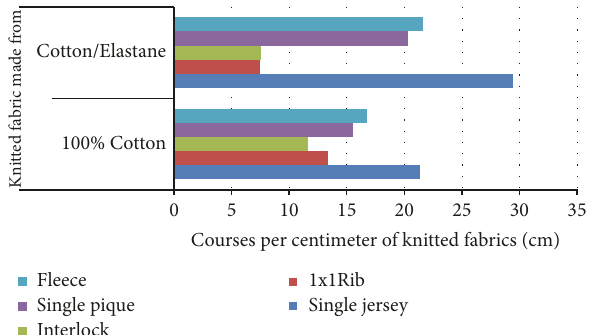
Figure 3: Courses per centimeter (cpc) of knitted fabrics made from 100% cotton and cotton/elastane